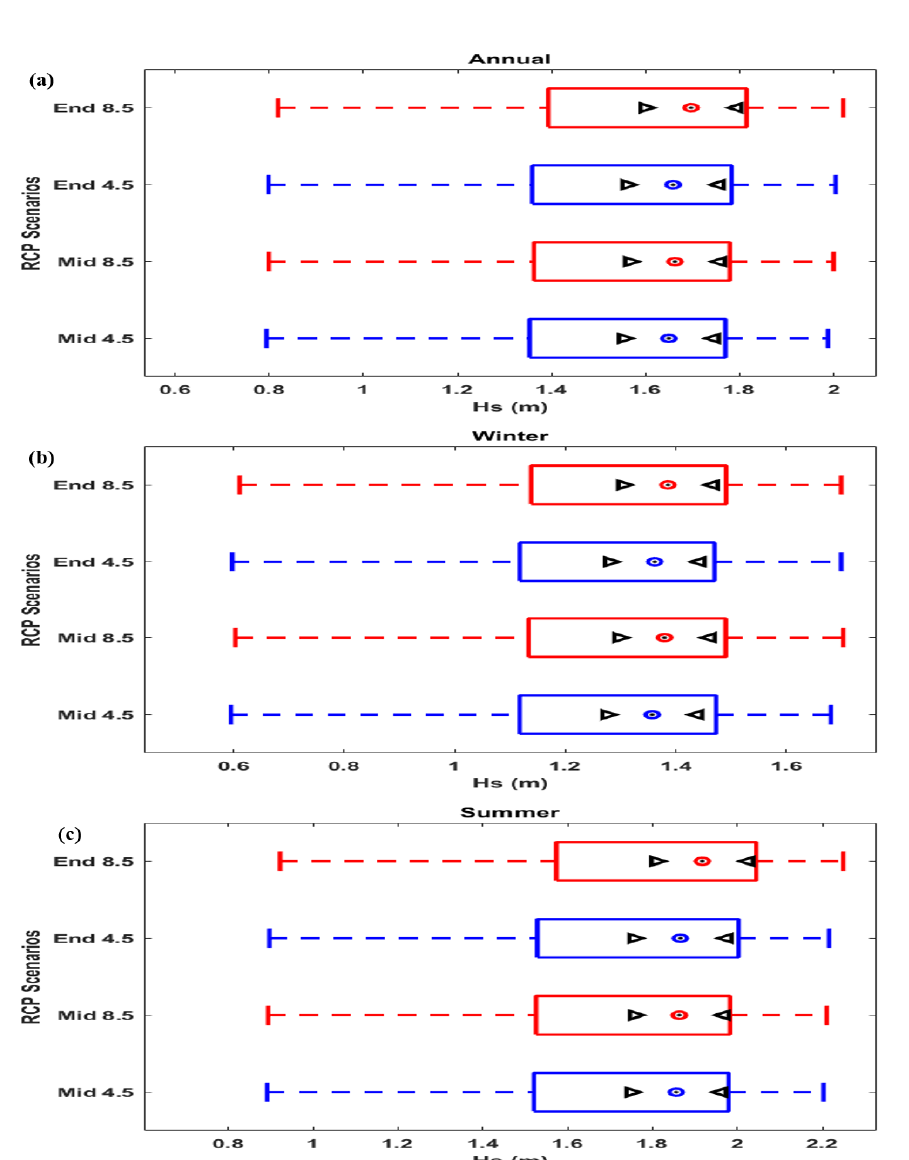
Figure 9. Boxplots showing the overlaps between Hs means for all future RCP scenarios with blue and red boxplots representing the RCP 4.5 and RCP 8.5, respectively for ( a ) annual ( b ) winter ( c ) summer.